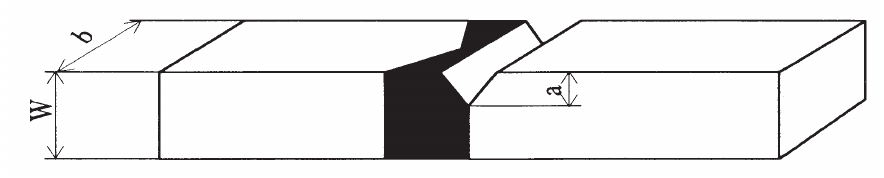
Figure 3: Dimensions of specimen and notch